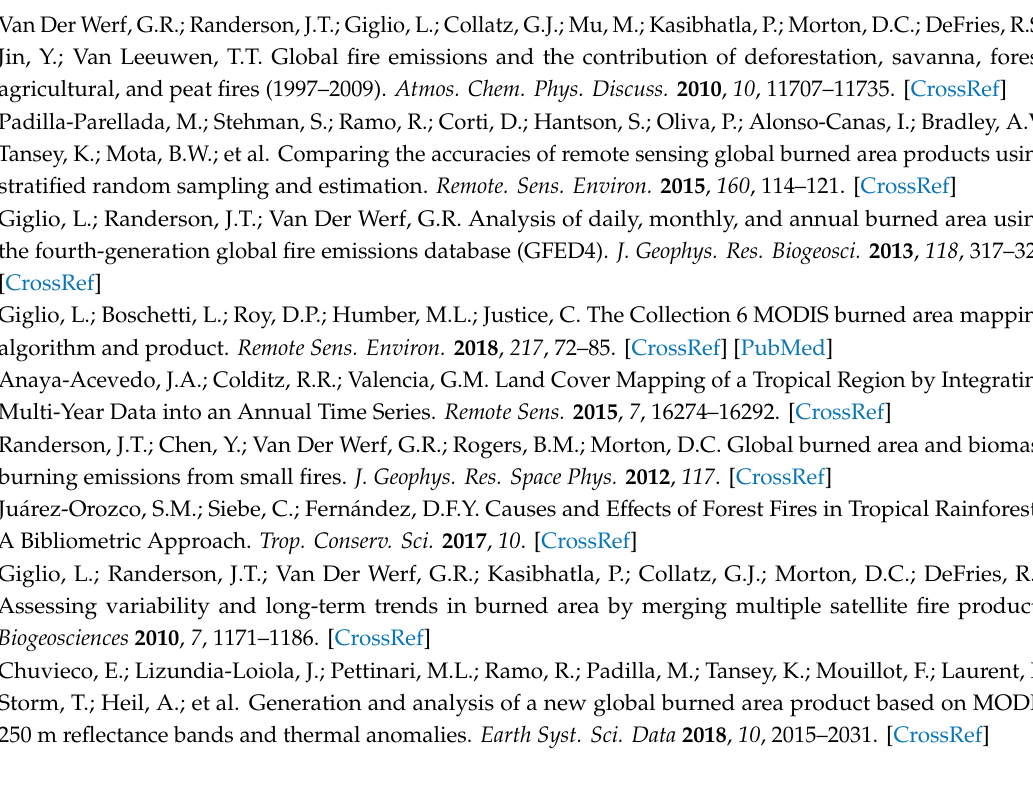
non centrality parameter of 3% to 93%. (a) Property (1) of Riemannian distance, red, black and green symbols corresponds to minimum, maximum and median values. (b) Property (2) of Riemannian distance, Figure S3-2. Simulated Full Procrustes Distance of 93 products perturbed from matrix L from a sample of 10.000 non central t distribution of 2 degrees of freedom and non centrality parameter of 3% to 93%. (a) Property (1) of Full Procrustes Distance, red, black and green symbols corresponds to minimum, maximum and median values. (b) Property (2) of Full Procrustes Distance, Figure S3-3. Simulated Partial Procrustes distance of 93 products perturbed from matrix L from a sample of 10.000 non-central t-distribution of 2 degrees of freedom and non centrality parameter of 3% to 93%. (a) Property (1) of Partial Procrustes Distance, red, black and green symbols corresponds to minimum, maximum and median values. (b) Property (2) of Partial Procrustes Distance, Table S2-1. Descriptive statistics of error matrices for Fire CCI 4.1, Table S2-2. Descriptive statistics of error matrices for MCD45C5.1, Table